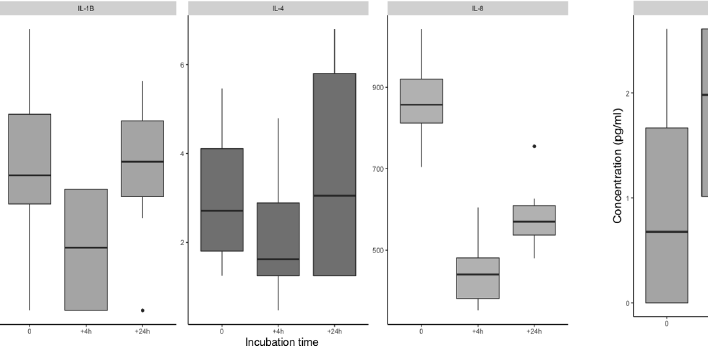
Figure 3. Incubation for 24 h - clarithromycin impact on pro- inflamma- tory mediators’ secretion. Figure shows the impact of clarithromycin, respectively, on IL-1β, IL-4 and IL-8 release by A459 cells. Before (incuba- tion time 0), after co-incubation (incubation time +24h), and 24 h after wash-out (incubation time + 24h), cell culture supernatants were ana- lysed for the presence of the indicated cytokines by Luminex®. Values are expressed as mean ± SEM from 4 independent experiments.